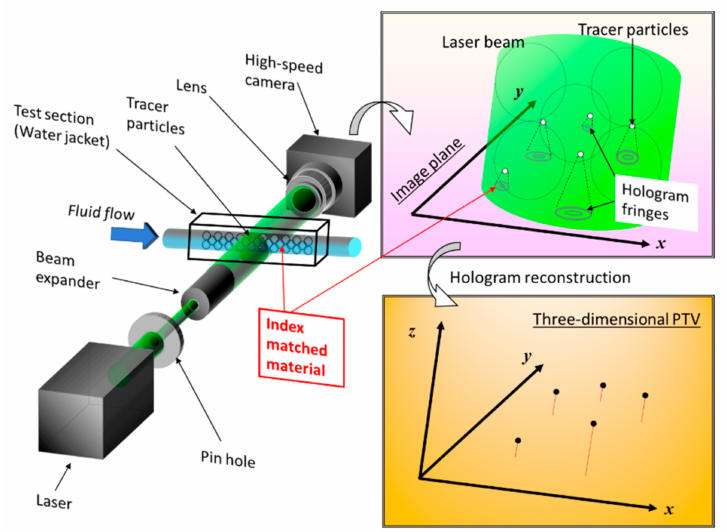
Figure 1. Example of a setting in which DHPTV is applied to an intra-tube flow in a tube filled with MEXFLON pebbles